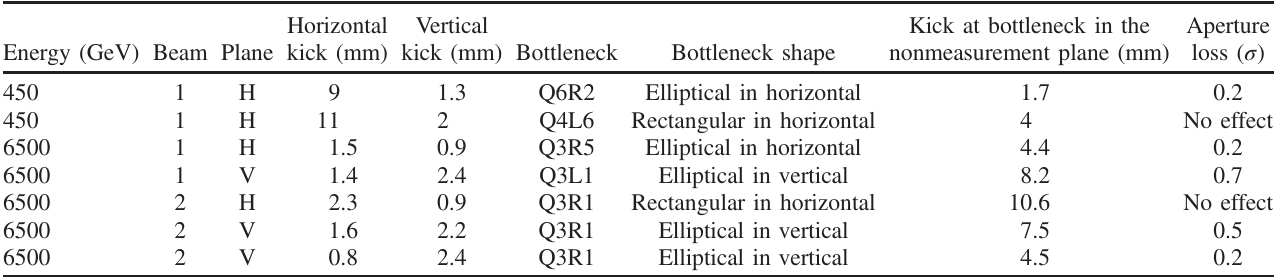
TABLE VII. Summary of the main parameters used and computed in the analysis of the impact of the ac-dipole kick on the nonmeasuring plane for the 2017 and the 2018 data. Energy (GeV) Beam